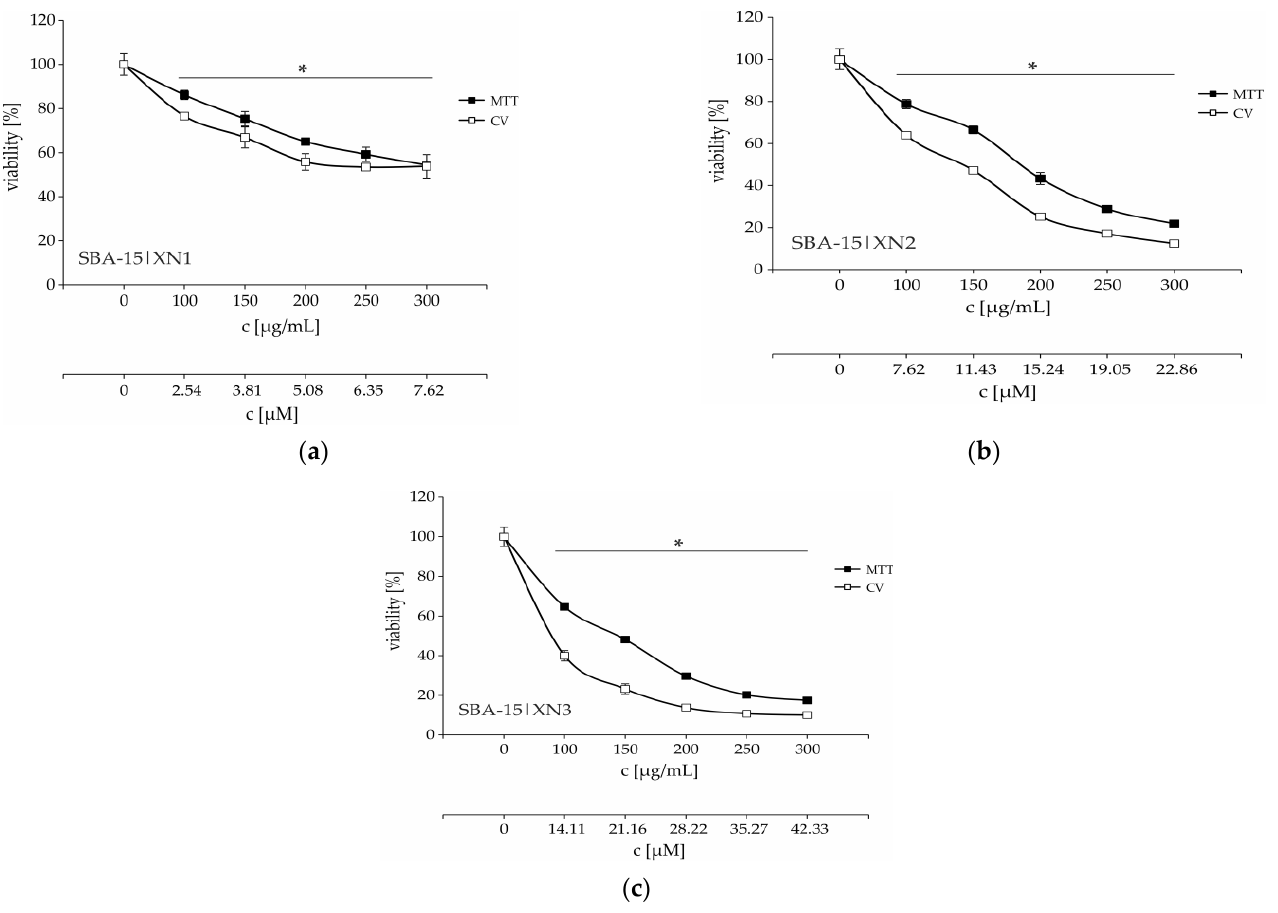
Figure 4. Dose-dependent viability decrease of B16F10 melanoma cells treated with various concen- trations of SBA-15|XN1 – SBA-15|XN3 ( a – c ) for 48 h. * p < 0.05 compared to the untreated control cells. c [  M] is calculated according to amount of XN by TGA.